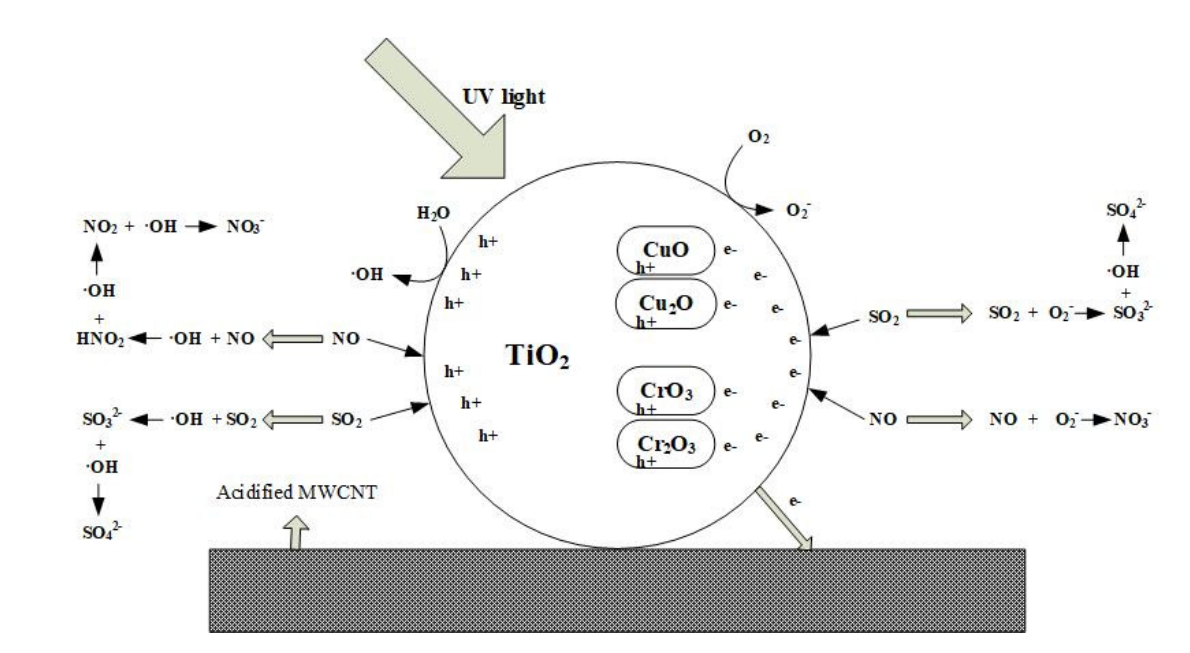
Figure 13. The reaction mechanism for the integrated removal of SO 2 and NO.